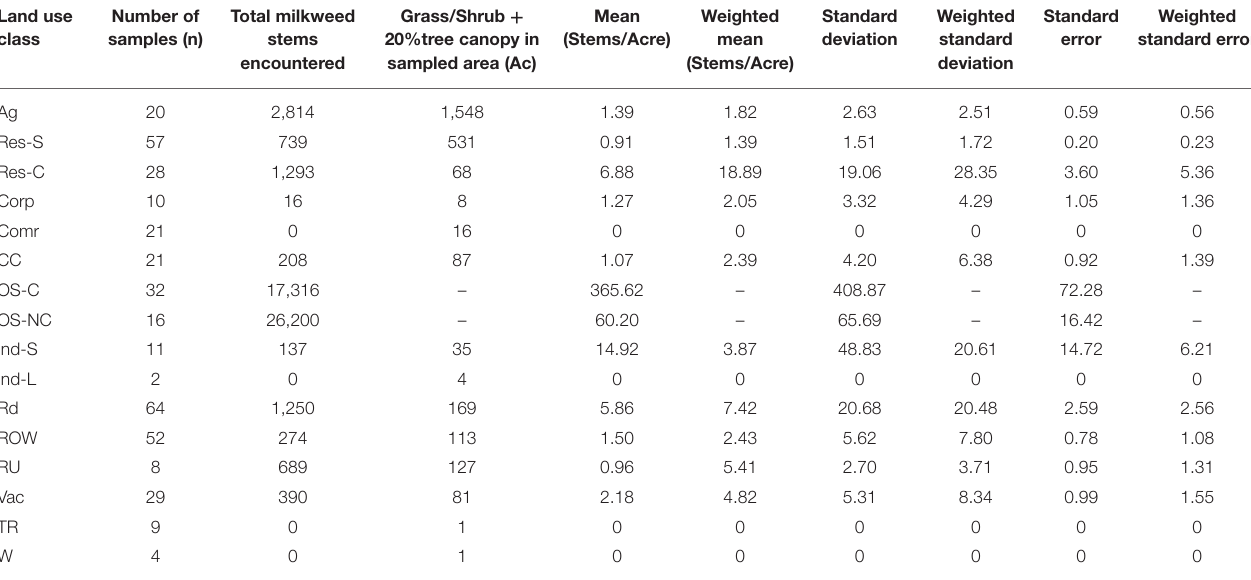
TABLE 2 | Chicago milkweed density survey results by land use class calculated on a “plantable space” basis, which leverages high-resolution land cover. Land use Number of class samples